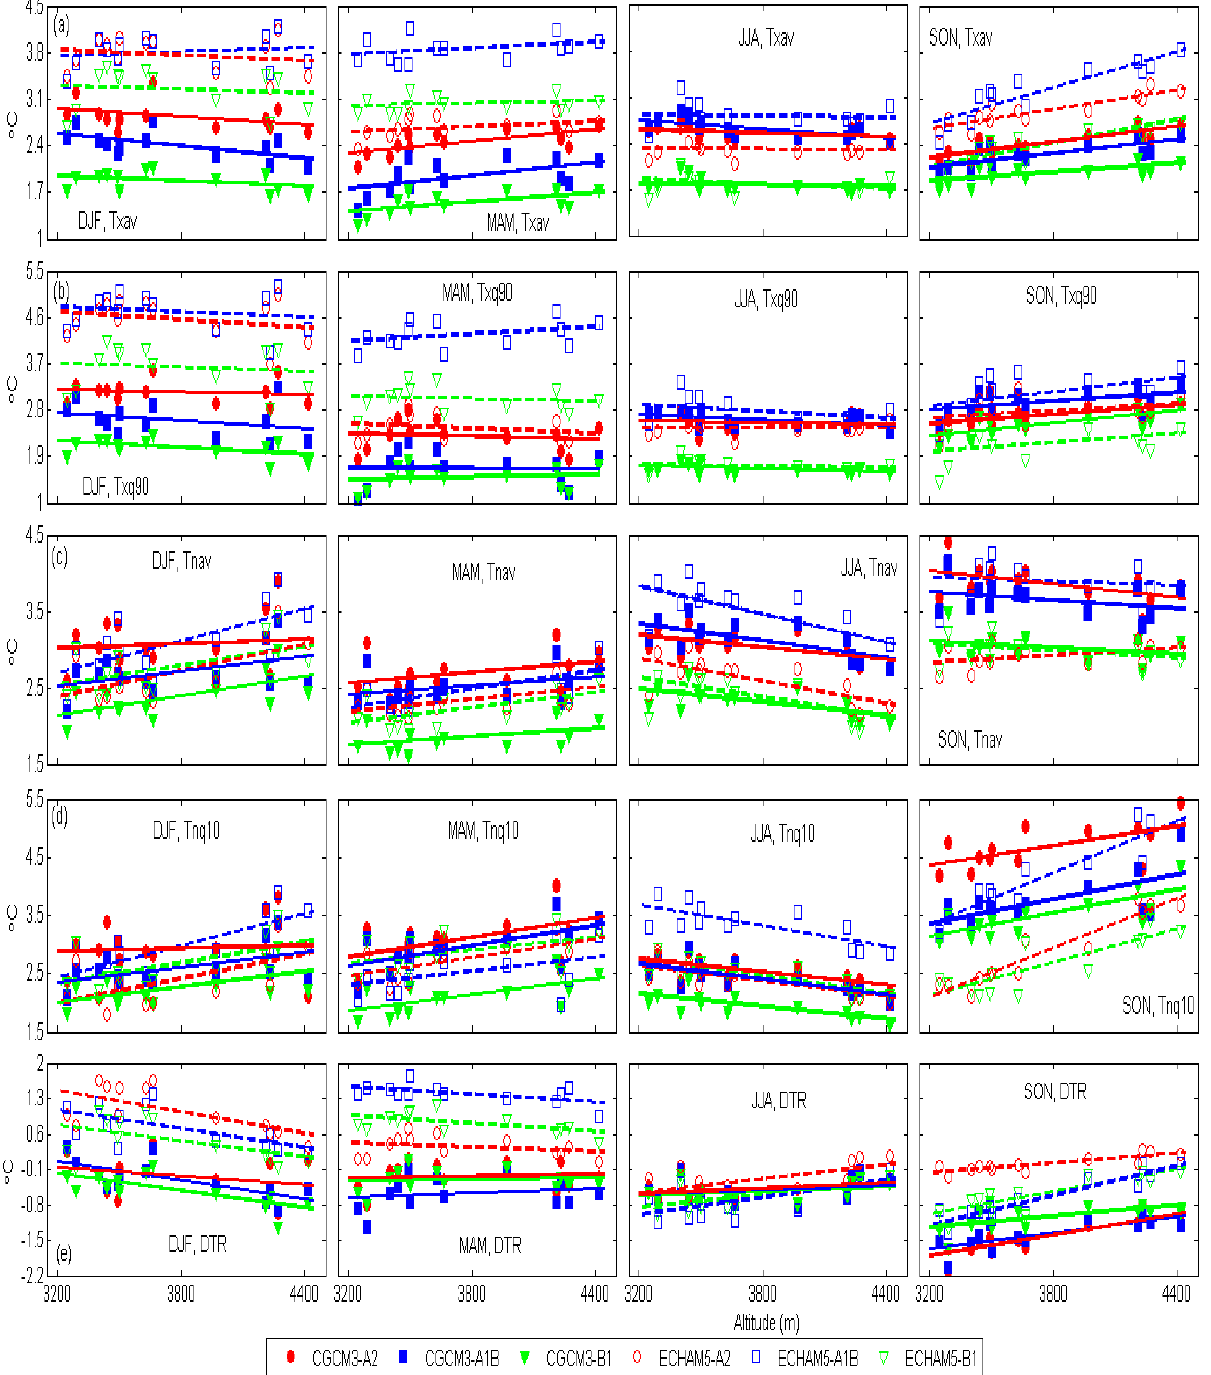
Fig. 4. Projected anomalies of the intensity-related indices (between 2046-2065 and 1961-1990) with station altitude for four seasons based on statistical downscaling outputs of two GCMs (CGCM3 and ECHAM5) under three emission scenarios (A2, A1B and B1).